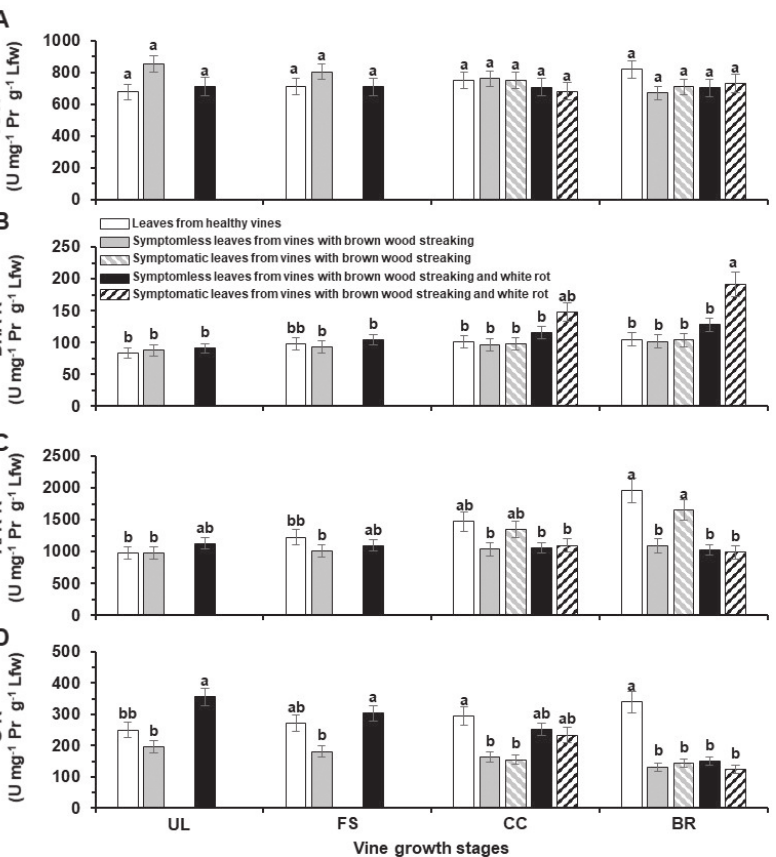
Figure 5. Activities of the redox enzymes: A) ascorbate peroxidase (APX), B) dehydroascorbate reductase (DHA-R), C) ascorbate free radi- cal reductase (AFR-R), D) glutathione reductase (G-R), D) ascorbate free radical reductase (AFR-R) in cv. Italia grapevine leaves, collected during unfolded leaf (UL), fruit set (FS), cluster closing (CC) and bunch ripening (BR) vine growth stages, from infected or healthy grape- vines. Data are means of 50 replicates ± standard deviations. For each parameter, values accompanied by the same letters are not signifi- cantly different ( P ≤ 0.05) according to Fisher’s LSD